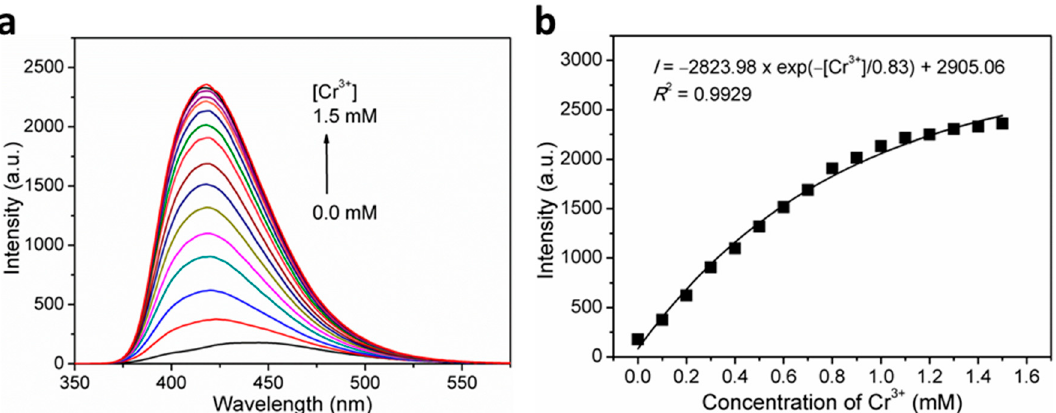
Figure 6. ( a ) Concentration-dependent fluorescence emission spectra of 1 in H 2 O suspensions upon incremental addition of Cr 3+ ions when excited at λ ex = 306 nm, and; ( b ) Plot of fluorescence intensity versus Cr 3+ ion concentration for 1 in H 2 O suspensions.